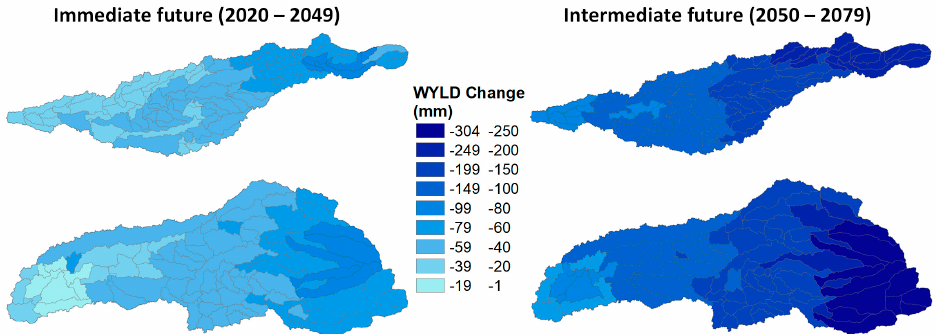
Figure 10. Changes in the yearly average discharge (WYLD) at the sub-basin scale, using RegCM4-MPI-ESM-MR, scenario RCP8.5.